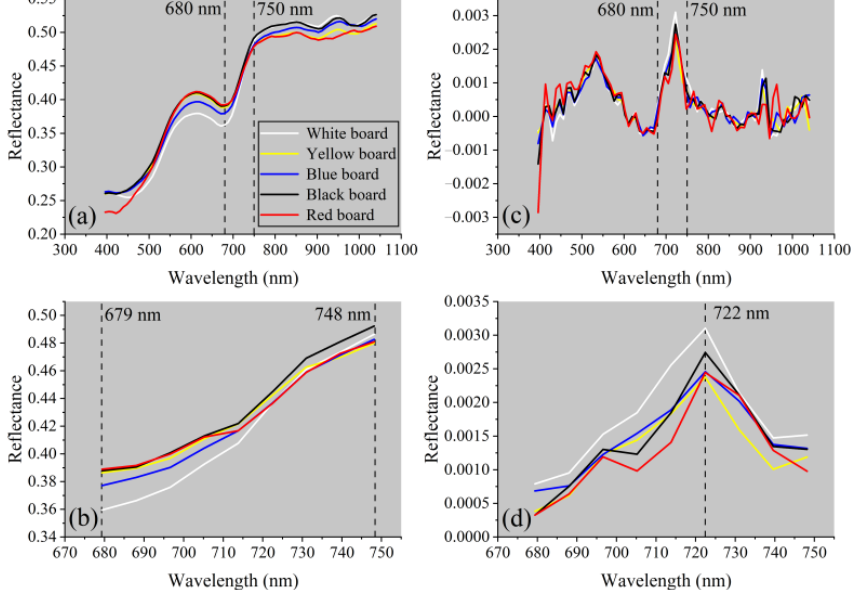
Figure 18. Spectral curve of PeITCs. ( a ) Spectral profiles of five verified PeITCs on ZY1-02D hyper- spectral imagery. ( b ) Magnified spectral profiles of five verified PeITCs in the red edge band. ( c ) First-order derivative spectral profiles of five verified PeITCs. ( d ) Magnification of the first-order derivative spectral curves of five verified PeITCs in the red edge band.